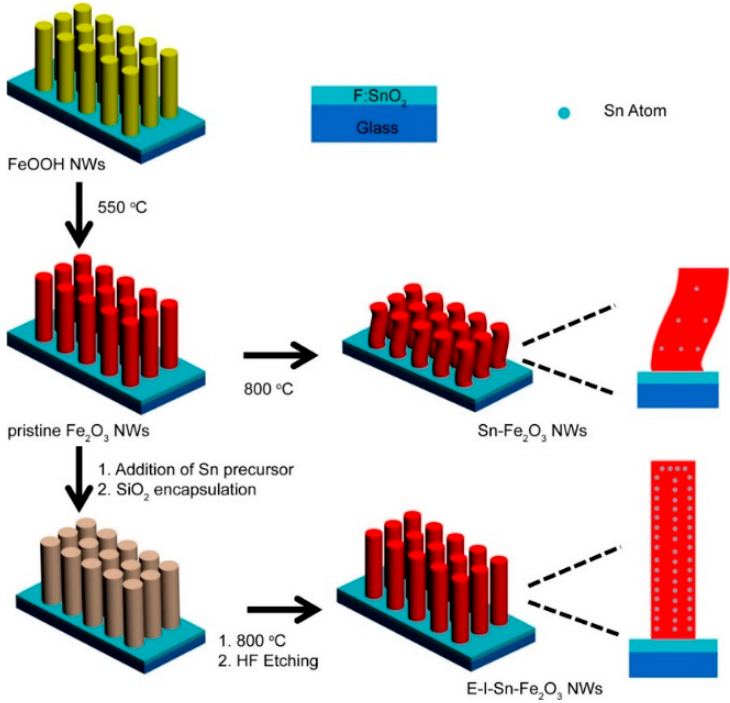
Figure 22. Synthetic protocol for Sn ‐ Fe 2 O 3 NWs and E ‐ I ‐ Sn ‐ Fe 2 O 3 NWs for further decoration with cobalt oxides (not shown). Reproduced from [69], with permission from the American Chemical Society, copyright 2017.